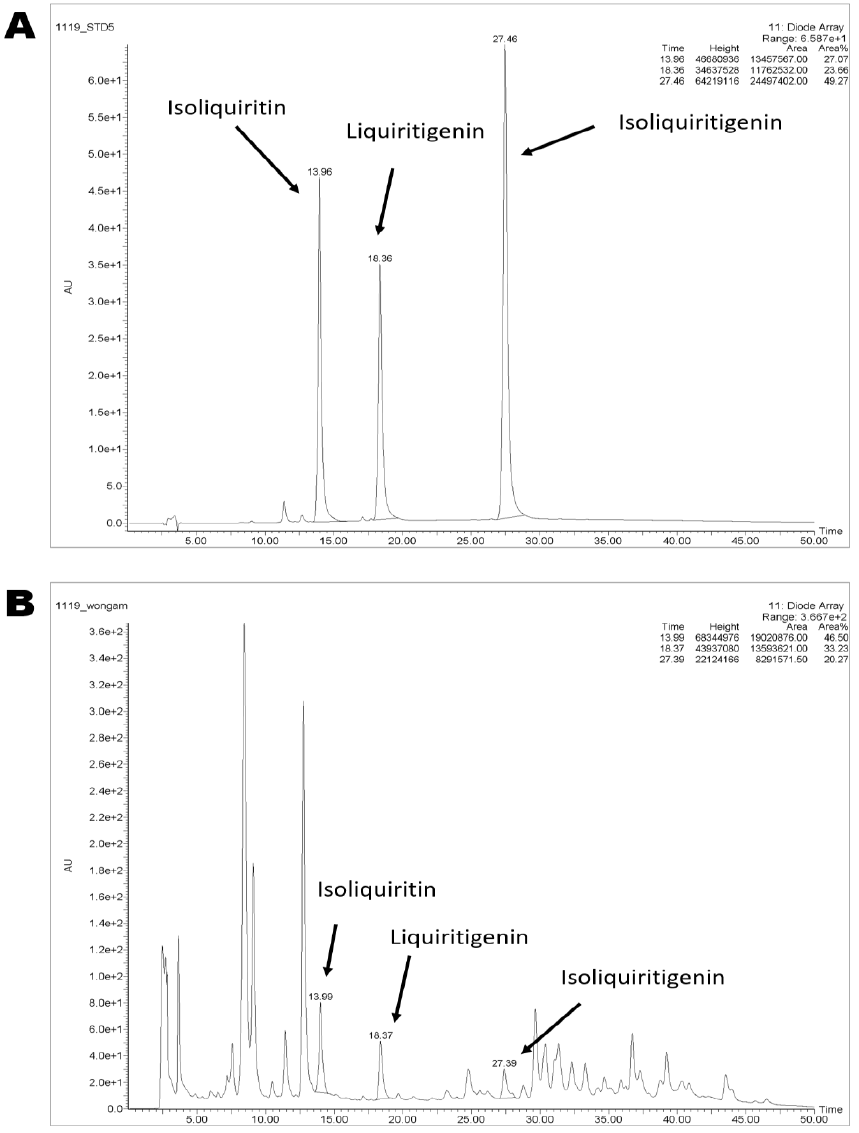
Figure 1. HPLC chromatograms of standard ( A ) isoliquiritin, liquiritigenin, and isoliquiritigenin. HPLC chromatograms of ( B ) WG extract.